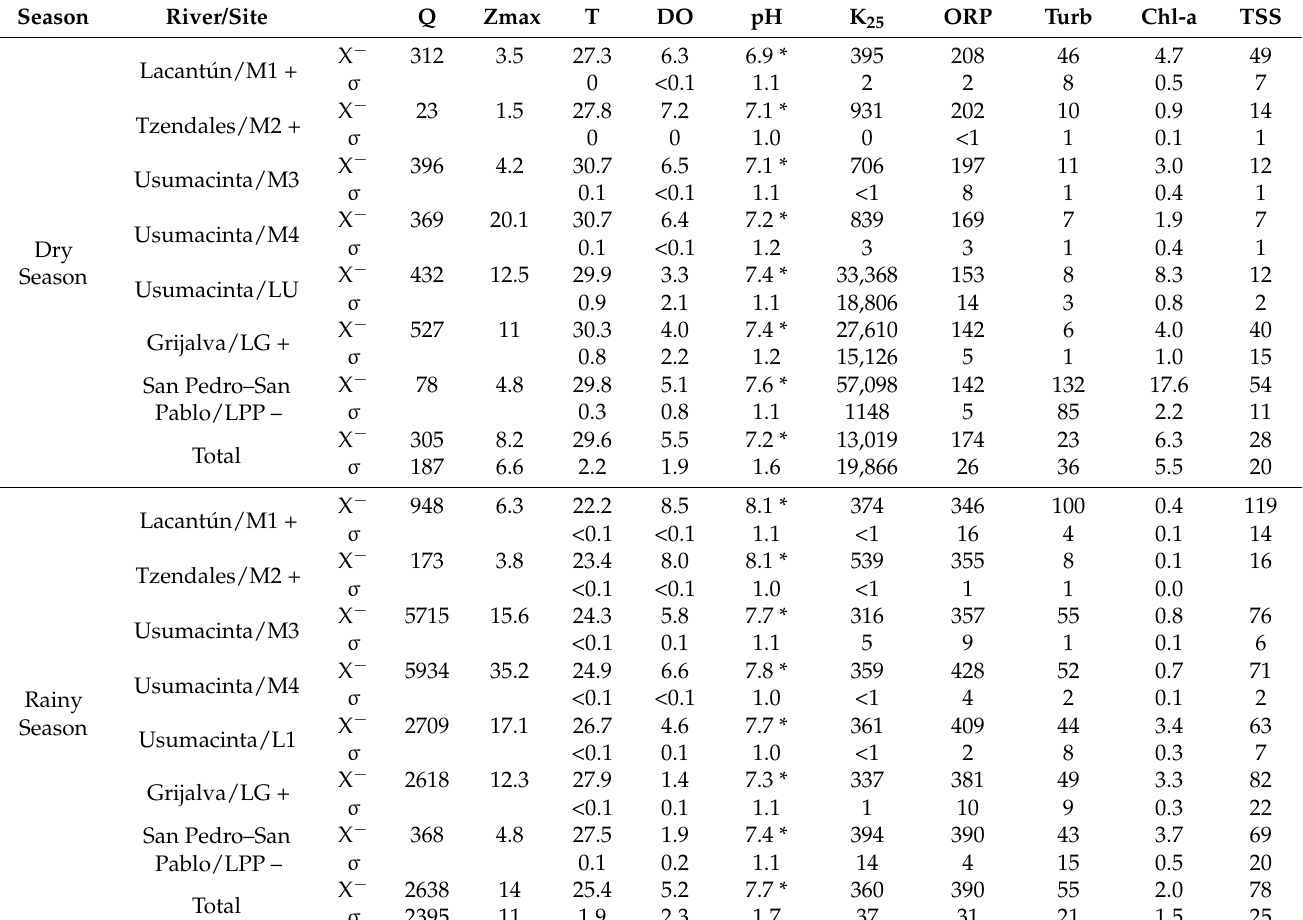
Table 1. Average (first line) and standard deviation (second line) values of water quality variables in the Usumacinta River main channel and major tributaries in the dry and rainy